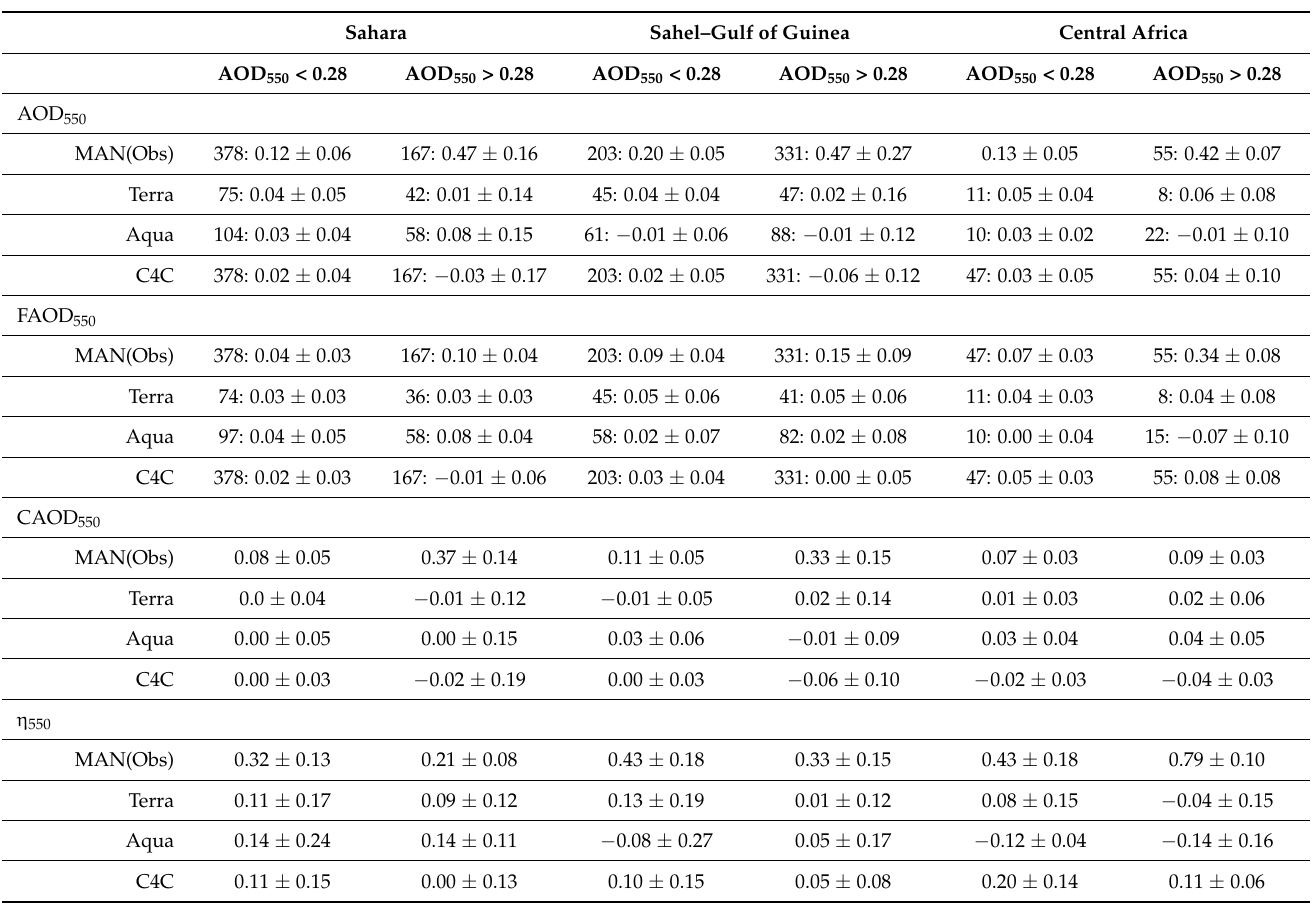
Table 5. Diagnostic error mean bias ± root mean square deviation for Terra and Aqua MODIS and the C4C consensus against MAN within two aerosol optical depth ranges in three regions along the western coast of Africa: Left columns, Saharan dust plume dominated (30–15 ◦ N; 15–35 ◦ W); middle columns, Sahel and Gulf of Guinea with a mixture of mixed dust, biomass burning and pollution sector from the Sahel into to the Gulf of Guinea (~15 ◦ N to the equator; 25 ◦ W to10 ◦ E); and right columns, biomass burning dominated central Africa (~equator to 15 ◦ S; 5 ◦ W − 15 ◦ E). The MAN observation means + standard deviations are also